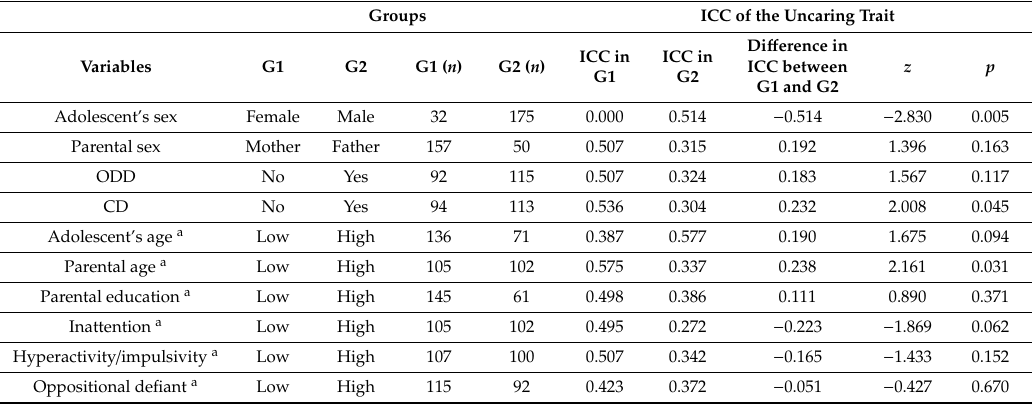
Table 5. Di ff erences in the agreement of adolescent–parent ratings on the uncaring trait in various groups of adolescents with ADHD. Groups ICC of the Uncaring